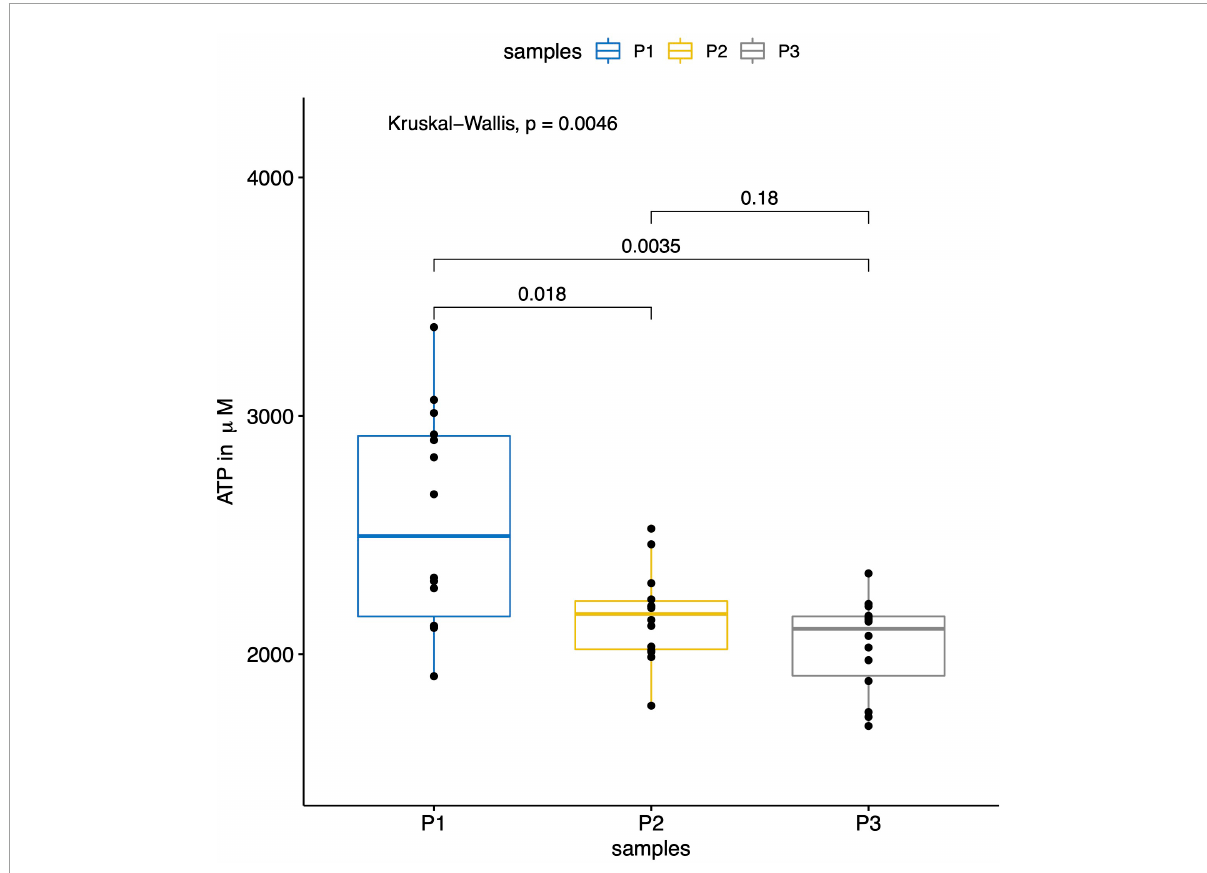
FIGURE5 The boxplot shows the results of the measured ATP levels (in µ M) within the parent vessel (P1) and the aneurysm sac before (P2) and after (P3) flow diversion. The AMP levels were significantly lower within the aneurysm sacs before (P2) and after (P3) flow diversion compared to the ones in the parent vessels (P1) ( p = 0.018 between P1 and P2, and p = 0.003 between P1 and